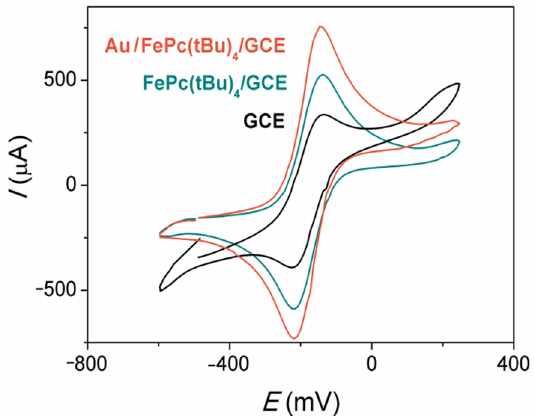
Figure 2. CV curves of the bare GCE, FePc(tBu) 4 /GCE, and Au/FePc(tBu) 4 /GCE in 2 mM [Ru(NH 3 ) 6 ]Cl 2 in 0.5 M KCl. Scan rate is 9.9 mV/s.